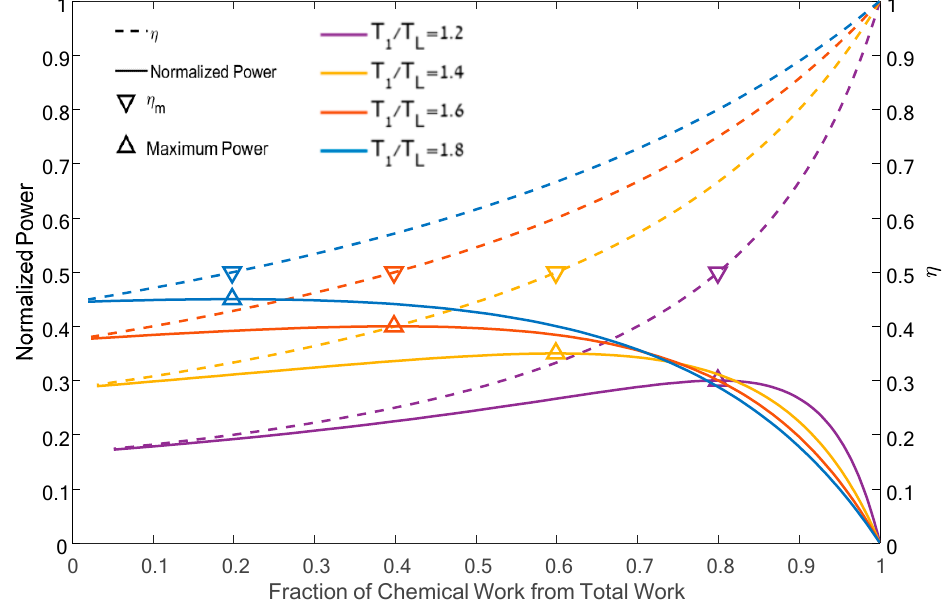
Figure2. E ffi Figure 2. Efficiency and normalized power of the cycle as a function of the electro-chemical work fraction.